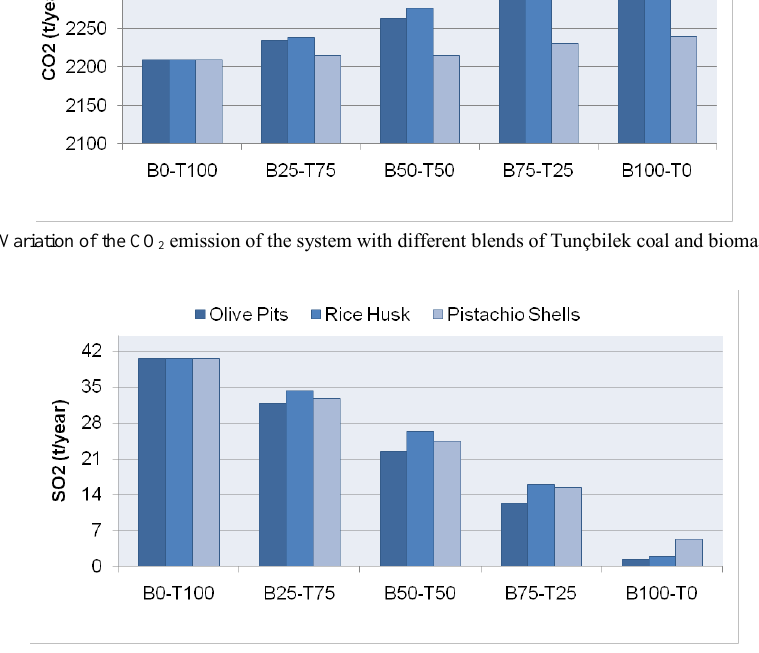
Fig. 5. Variation of the SO 2 emission of the system with different blends of Tunçbilek coal and biomass types. R